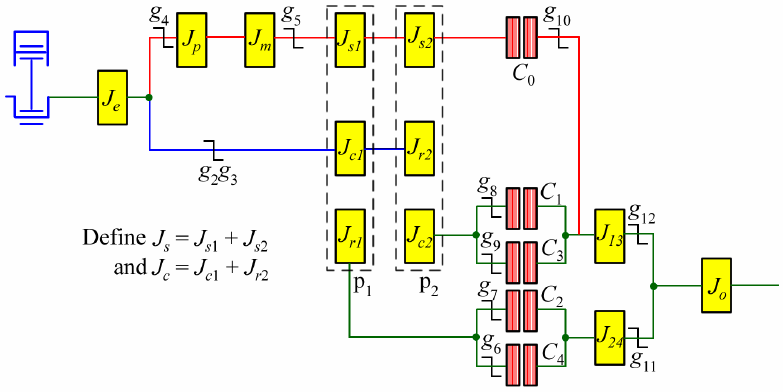
Figure 4. Distribution of equivalent moment of inertia.